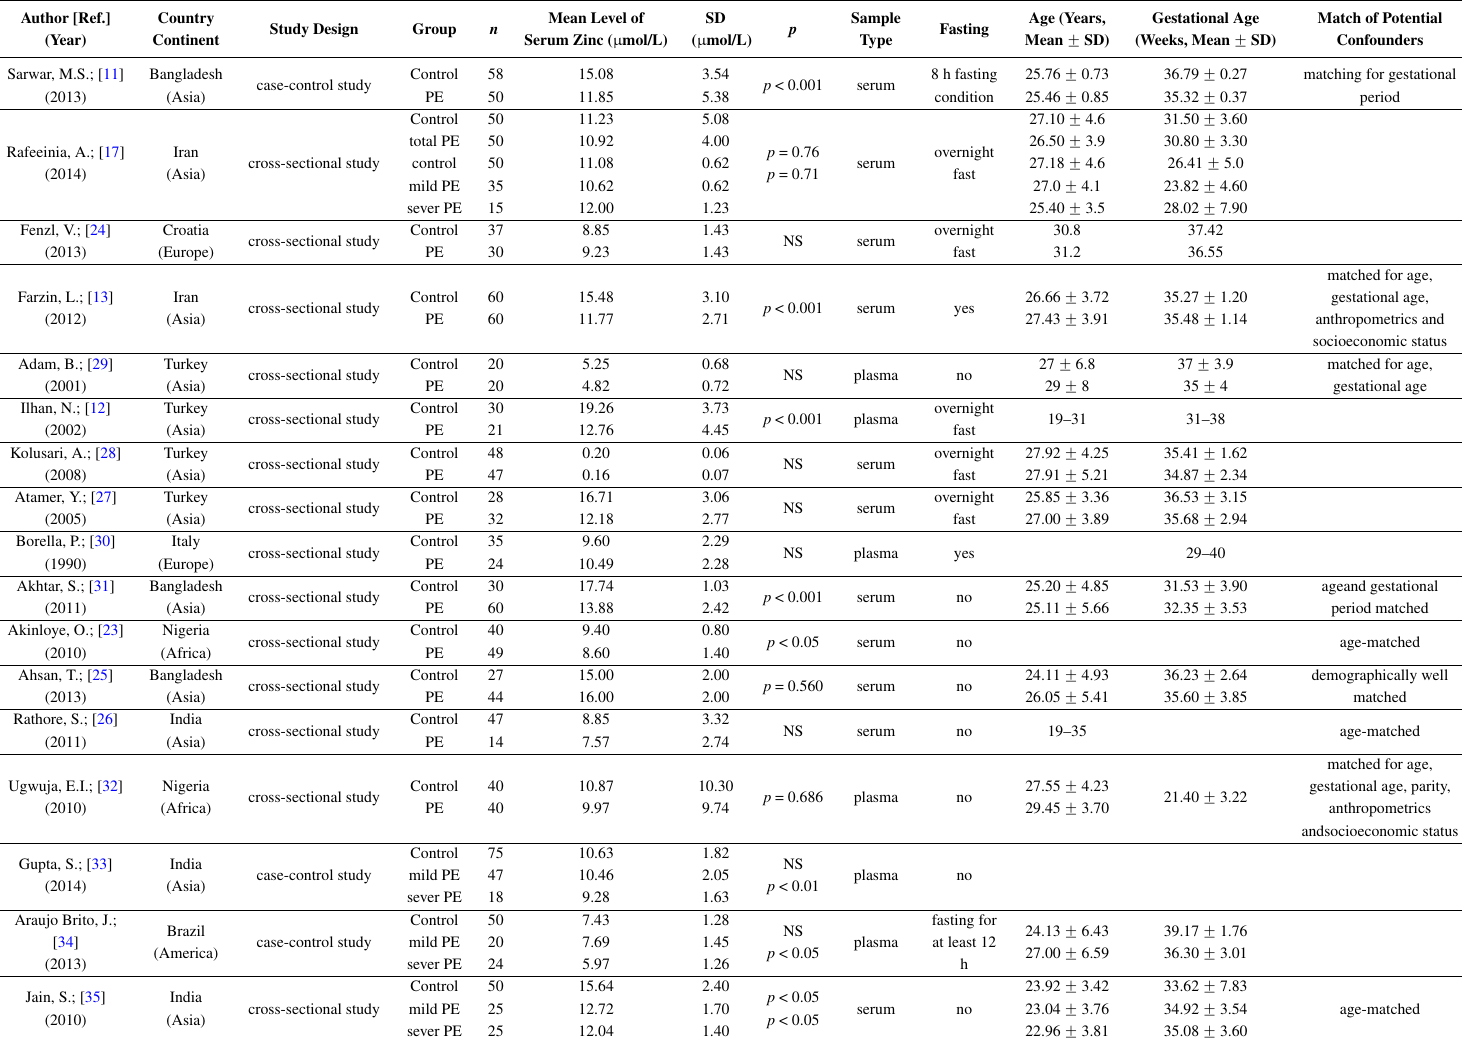
Table 1. Characteristics of 17 including studies.